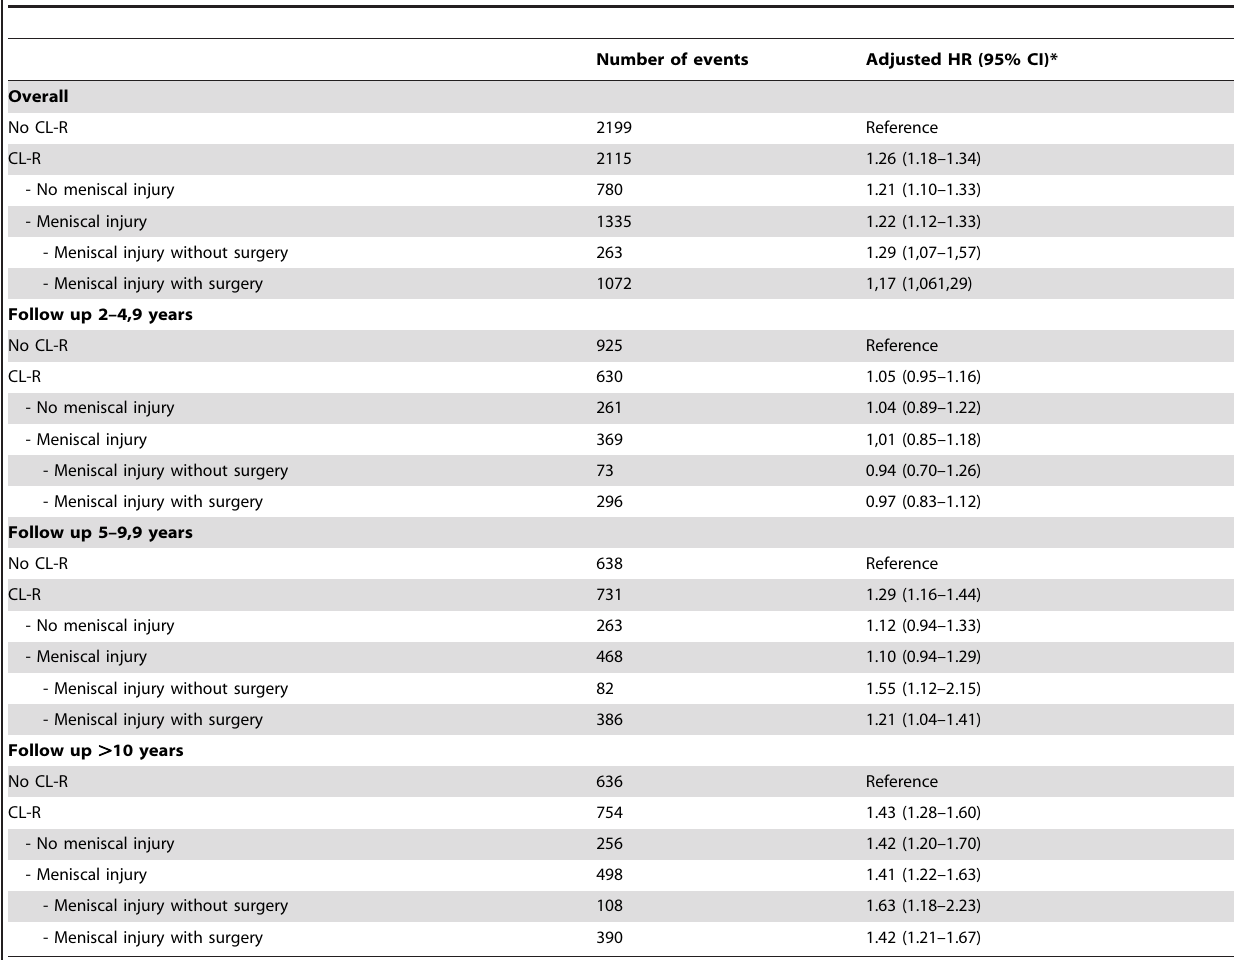
Table 2. Hazard ratio (HR) and 95% confidence interval (CI) for the association between crucial ligament reconstruction and knee osteoarthritis, according to meniscal injury and follow-up.